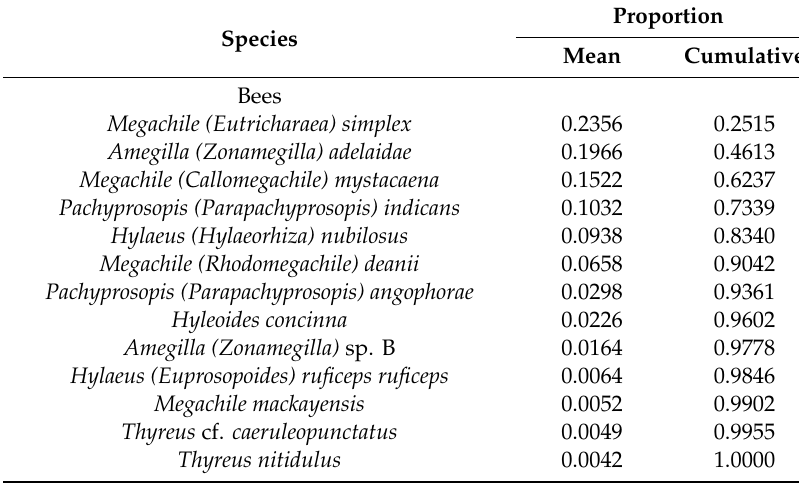
D (found only in